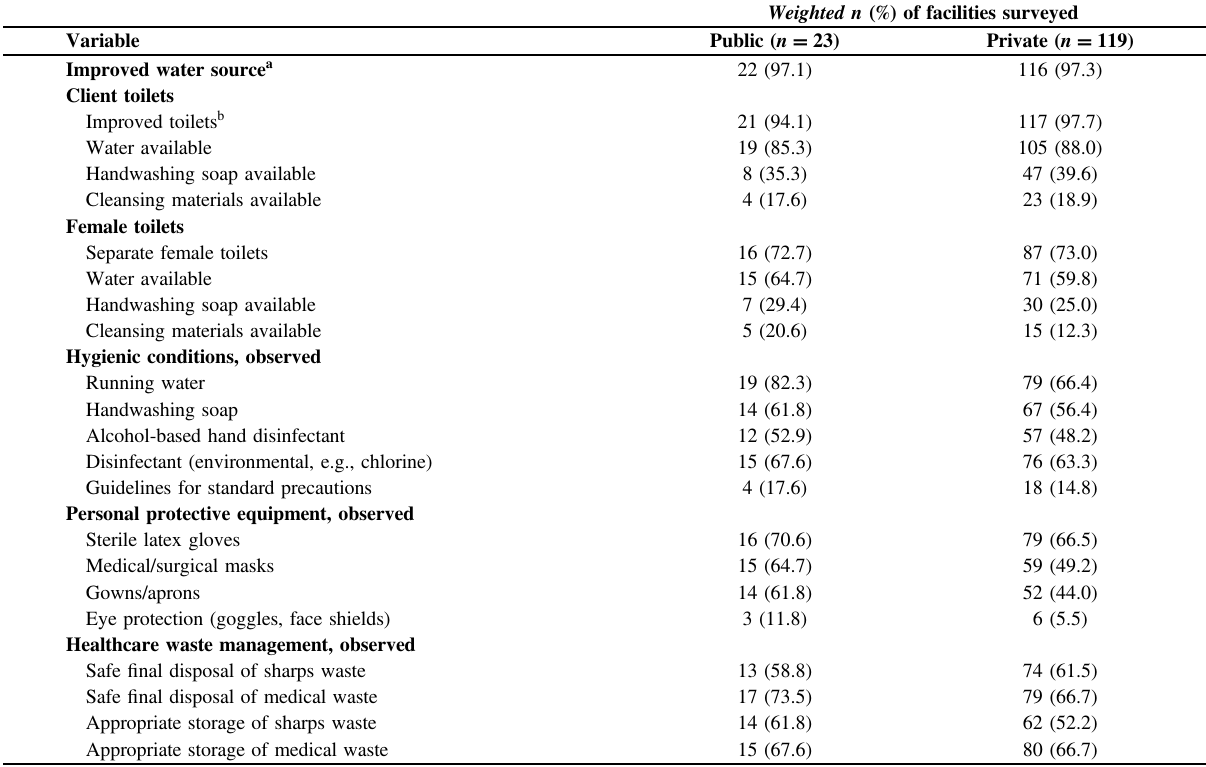
Table 2 Availability of water, sanitation and hygiene services and standard precautions in general outpatient areas, and healthcare waste management by managing authority, N =